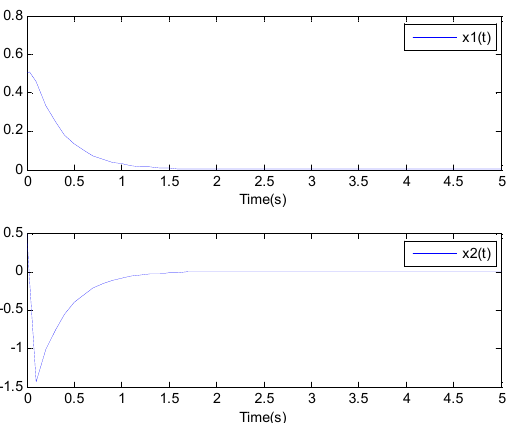
Figure 16. The continuous closed loop curves for the model (25) controlled by the discrete law using x (0) = [ − 0.5, 0.5].